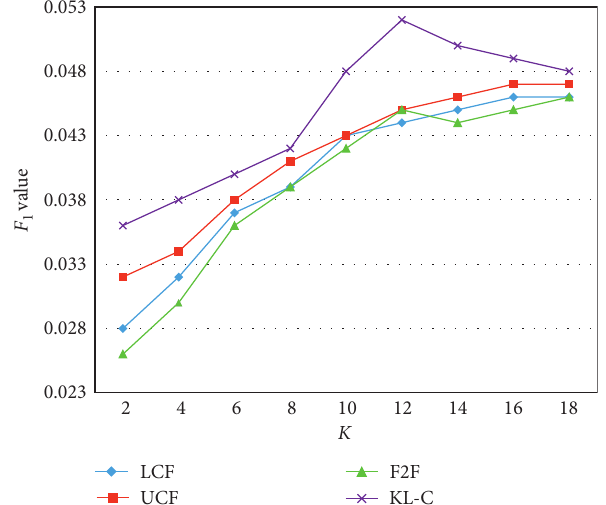
Figure 6: The effect of K value on the recommendation